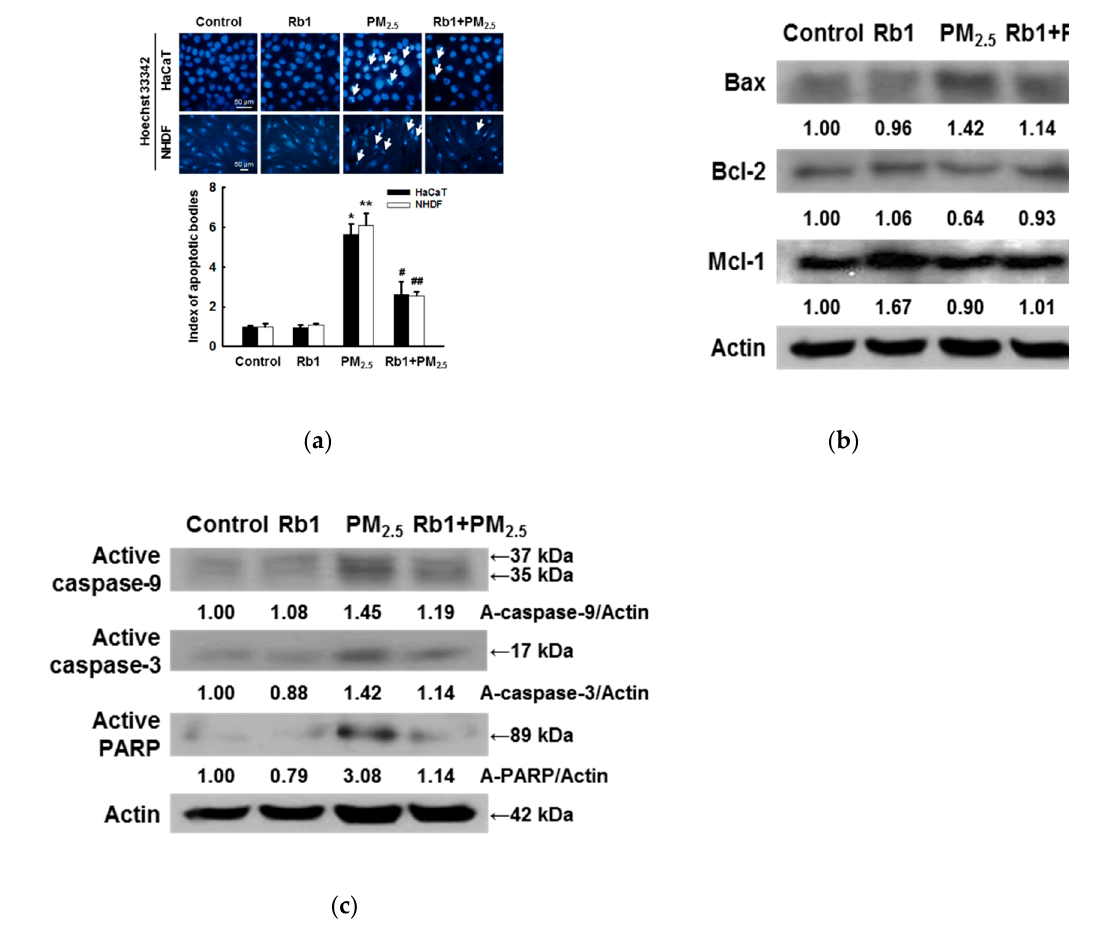
Figure 6. Ginsenoside Rb1 confers protection against PM 2.5 -induced apoptosis. ( a ) Cells were pre-treated with ginsenoside Rb1 for 1 h, followed by treatment with PM 2.5 (50 µg/mL) for 24 h, and then analyzed for apoptotic body formation by Hoechst 33342 staining. Apoptotic bodies are indicated by arrows. *,** p < 0.05 compared to the control groups of both HaCaT and NHDF cells, respectively; # , ## p < 0.05 compared to PM 2.5 -treated groups of both HaCaT and NHDF cells, respectively. ( b ) HaCaT cell lysates were analyzed for the expression of Bax, Bcl-2, and Mcl-1 by western blotting; actin was used as a loading control. ( c ) The expression of caspase-3, caspase-9, and PARP was also analyzed; actin was used as a loading